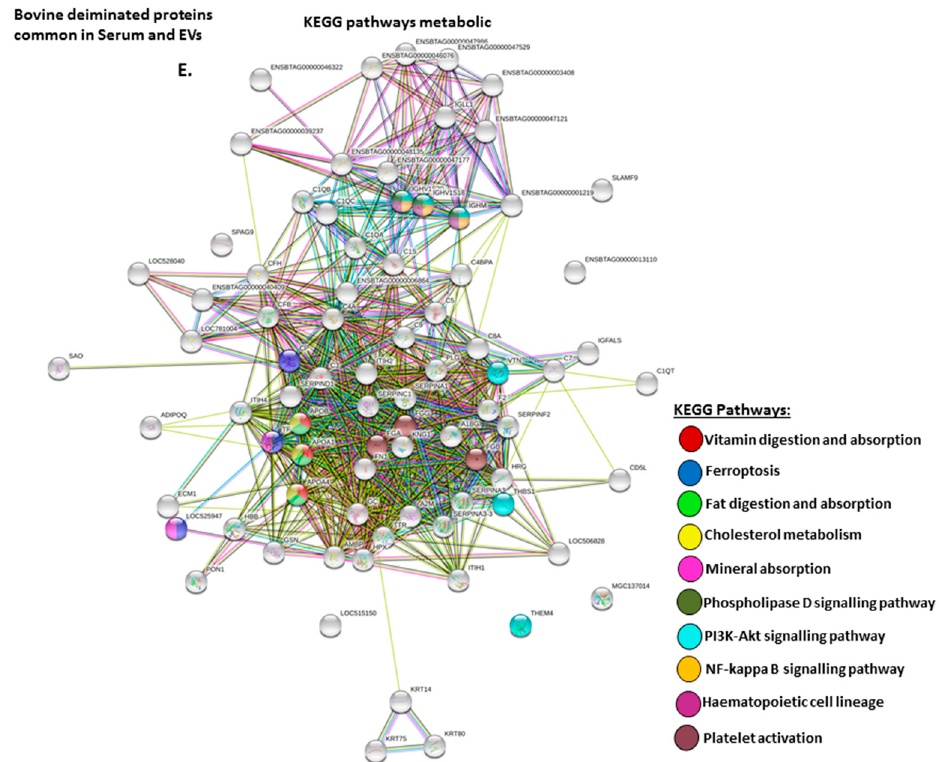
Figure 8. Protein–protein interaction networks for common deiminated protein candidates identified in bovine serum and serum-EVs (excluding serum-specific or EV specific candidates). Protein–protein interactions were reconstructed based on both known and predicted interactions by STRING analysis. ( A ) Query proteins are indicated by the coloured nodes and represent the first shell of interactors. ( B ) KEGG pathways for to the identified deiminated proteins and reported in STRING and relating to infection are highlighted (see colour code included in the figure). ( C ) KEGG pathways relating to the identified proteins and reported in STRING are highlighted for immunity (see colour code included in the figure). ( D ) KEGG pathways relating to cancer and disease for deiminated proteins identified are highlighted for (see colour code included in the figure). ( E ) KEEG pathways relating to metabolism for deiminated proteins identified are highlighted (see colour code included in the figure). The coloured lines highlight which protein interactions are identified through known interactions (this refers to curated databases, experimentally determined), through predicted interactions (this refers to gene neighborhood, gene fusion, gene co-occurrence) or through co-expression, text mining or protein homology (the colour key for connective lines is included in the figure).